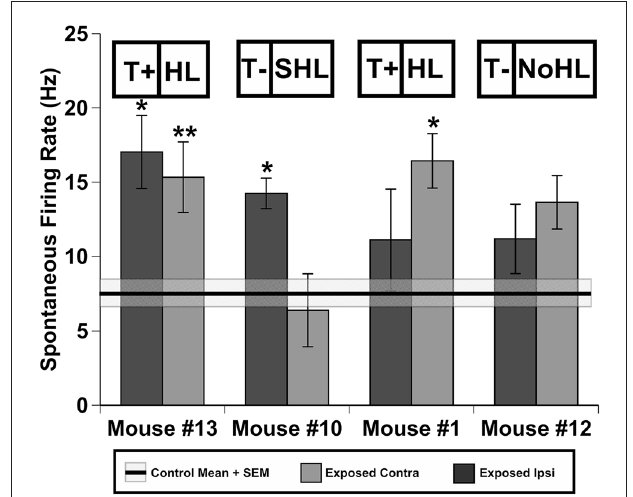
FIGURE 4 | Spontaneous firing of inferior colliculus (IC) neurons in four individual mice after sound exposure . Data represents means and standard errors of spontaneous rate (SR)s of contra- and ipsi-lateral ICs (relatively to the exposed ear) for each mouse. Signifcant differences ( ∗ 0.05, ∗∗ 0.001) between each IC of exposed mice and averaged values across four control (unexposed) animals (black line = mean, shaded region = std. error). Tinnitus and hearing loss abbreviations are taken from Figures 1 , 2